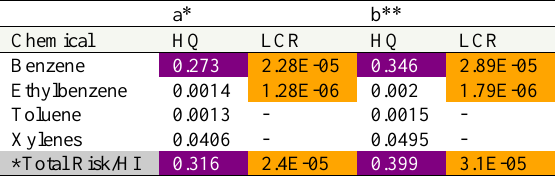
Table 6. LCR and HQ of BTEX compounds based on type of